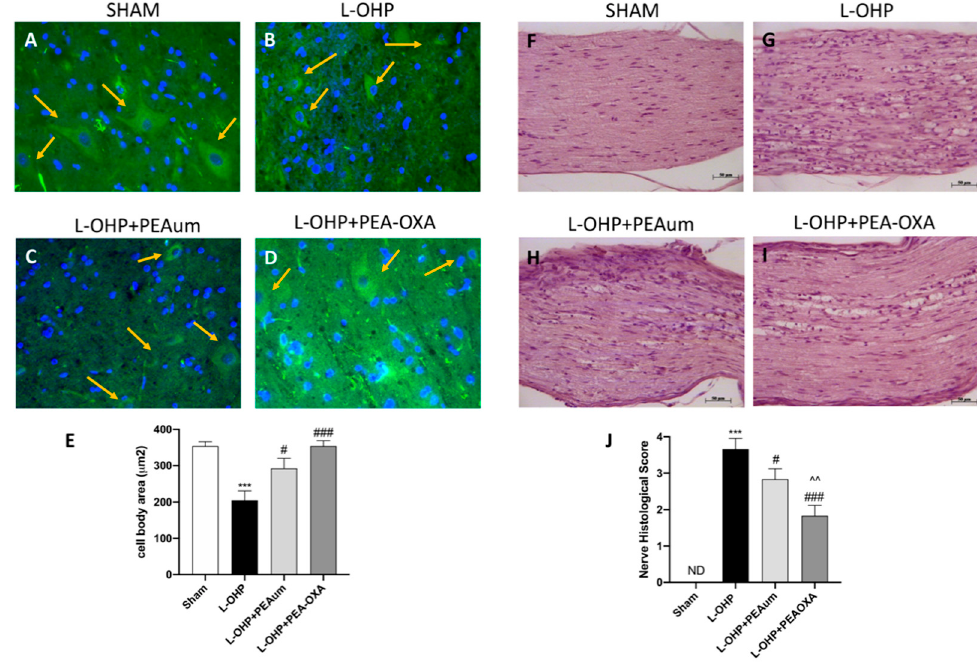
Figure 2. Effect of PEA-OXA on neuronal and peripheral nerve morphology. The immunofluorescence staining for β -III tubulin (green) and 4 ′ ,6 ′ -diamidino-2-phenylindole (DAPI) (blue) was made on lumbar spinal cord. L-OHP injection changed neuronal morphology ( B , E ), compared to sham group ( A , E ), while PEA-OXA significantly preserved neuronal shape ( D , E ) much more then PEAum ( C , E ). Scale bar = 20 μ m (particle). Hematoxylin and eosin (H&E) was made on sciatic nerve 25 days following L-OHP injection. PEA-OXA significantly preserved sciatic nerve tissue architecture degeneration ( I , J) , more than PEAum ( H , J ), compared to L-OHP group ( G , J ). Data are representative of at least three independent experiments. Values are means ± SEM of 20 animals for each group. One-way ANOVA test; *** p < 0.001 vs. sham; # p < 0.05 vs. L-OHP; ### p < 0.001 vs. L-OHP; ^^ p < 0.01 vs. PEAum.